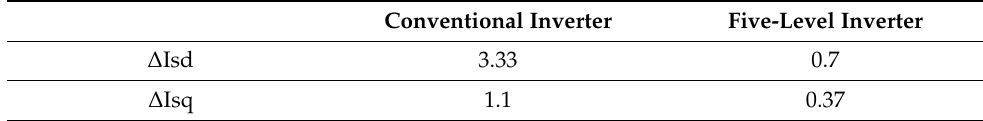
Table 5. ∆ Isd and ∆ Isd of two- and five-level